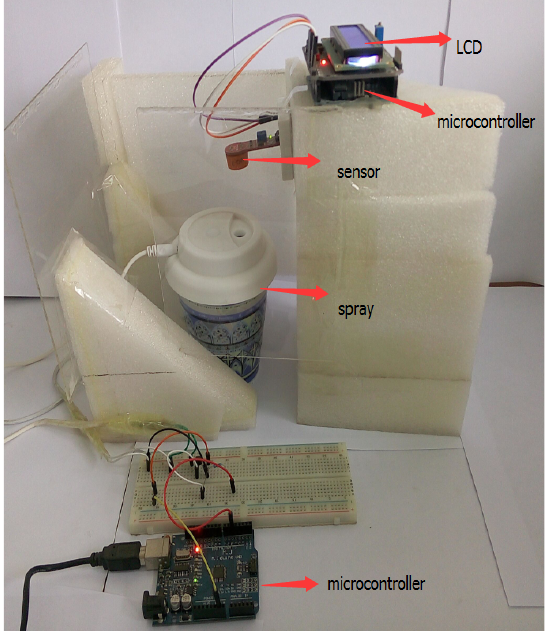
Figure 3: A test-bed of Molecular Communication